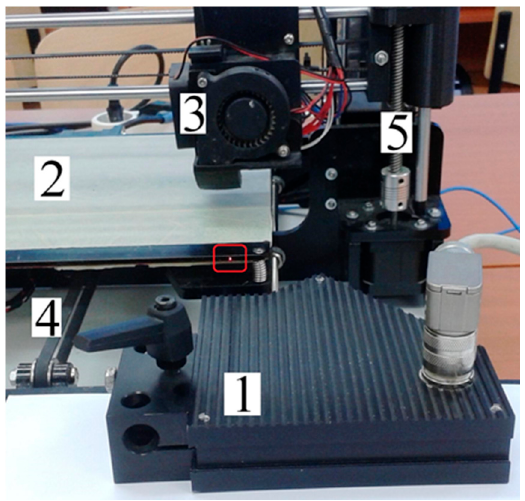
Figure 1. A partial view of the setup with optical sensor on y -axis. 1-optical sensor; 2-print bed; 3-the extruder system; 4-toothed belt for y -axis displacement; 5-first screw for z -axis